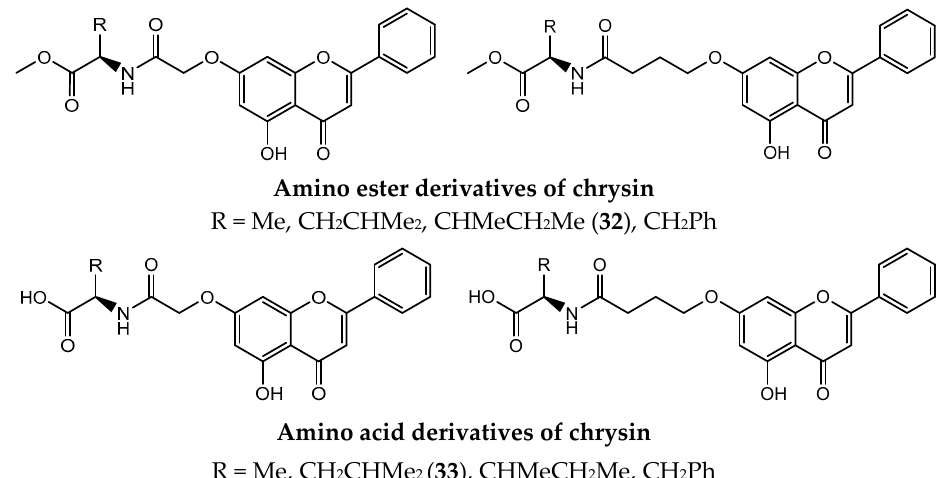
Figure 10. Chemical structure of amino acid derivatives and amino acid ester derivatives of chrysin.